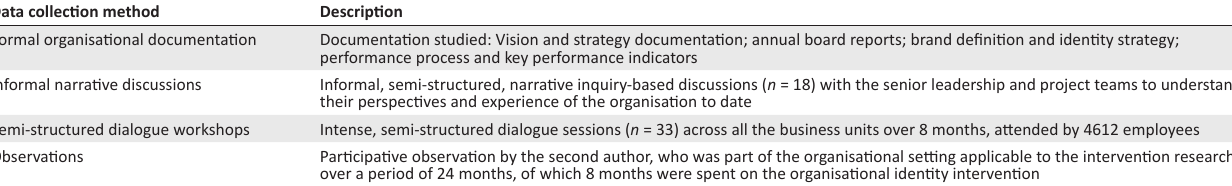
TABLE 1: Data collection approach and methods applied during the organisational identity